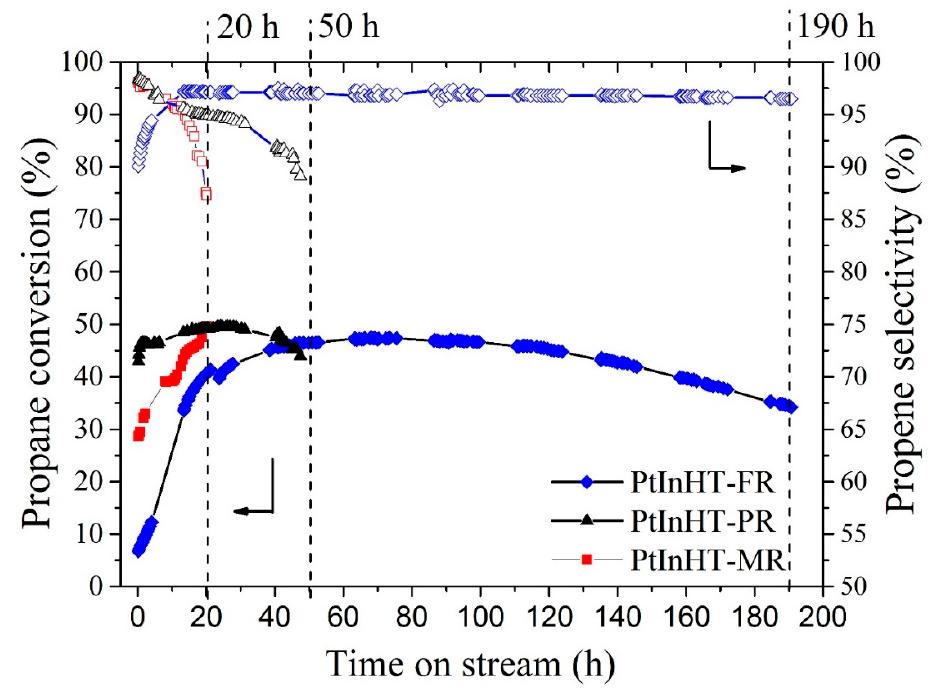
Figure 6. Propane conversion and propene selectivity as functions of time for different catalysts (reaction conditions: T = 600 °C, H 2 :C 3 H 8 :N 2 = 7:8:35 (molar ratio), weight hourly space velocity (WHSV) = 3 h − 1 , m cat = 0.4 g).